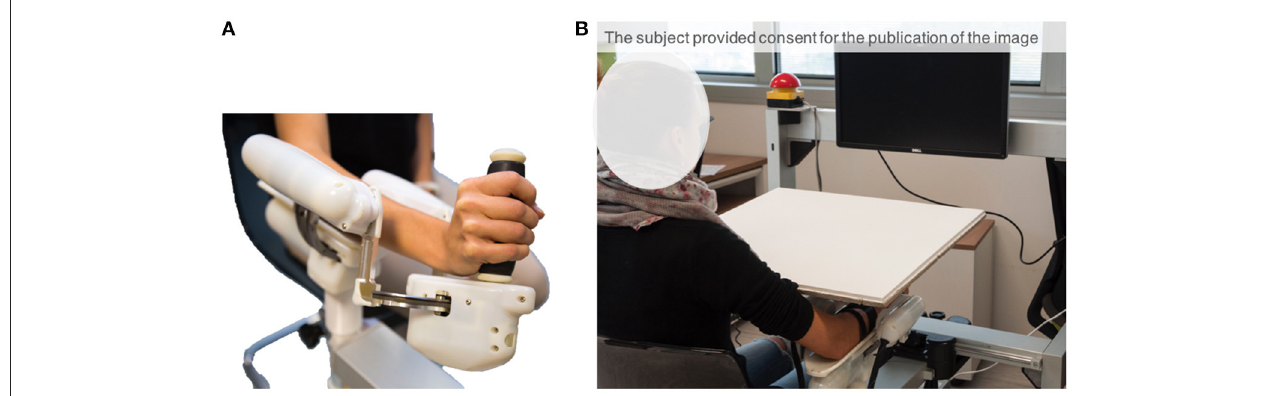
FIGURE 1 | (A) Wrist robotic device. (B) Experimental set-up comprising the robot and the computer screen. Subject’s wrist and the robot were visually occluded through a board, so as to engage only the sense of proprioception when performing the